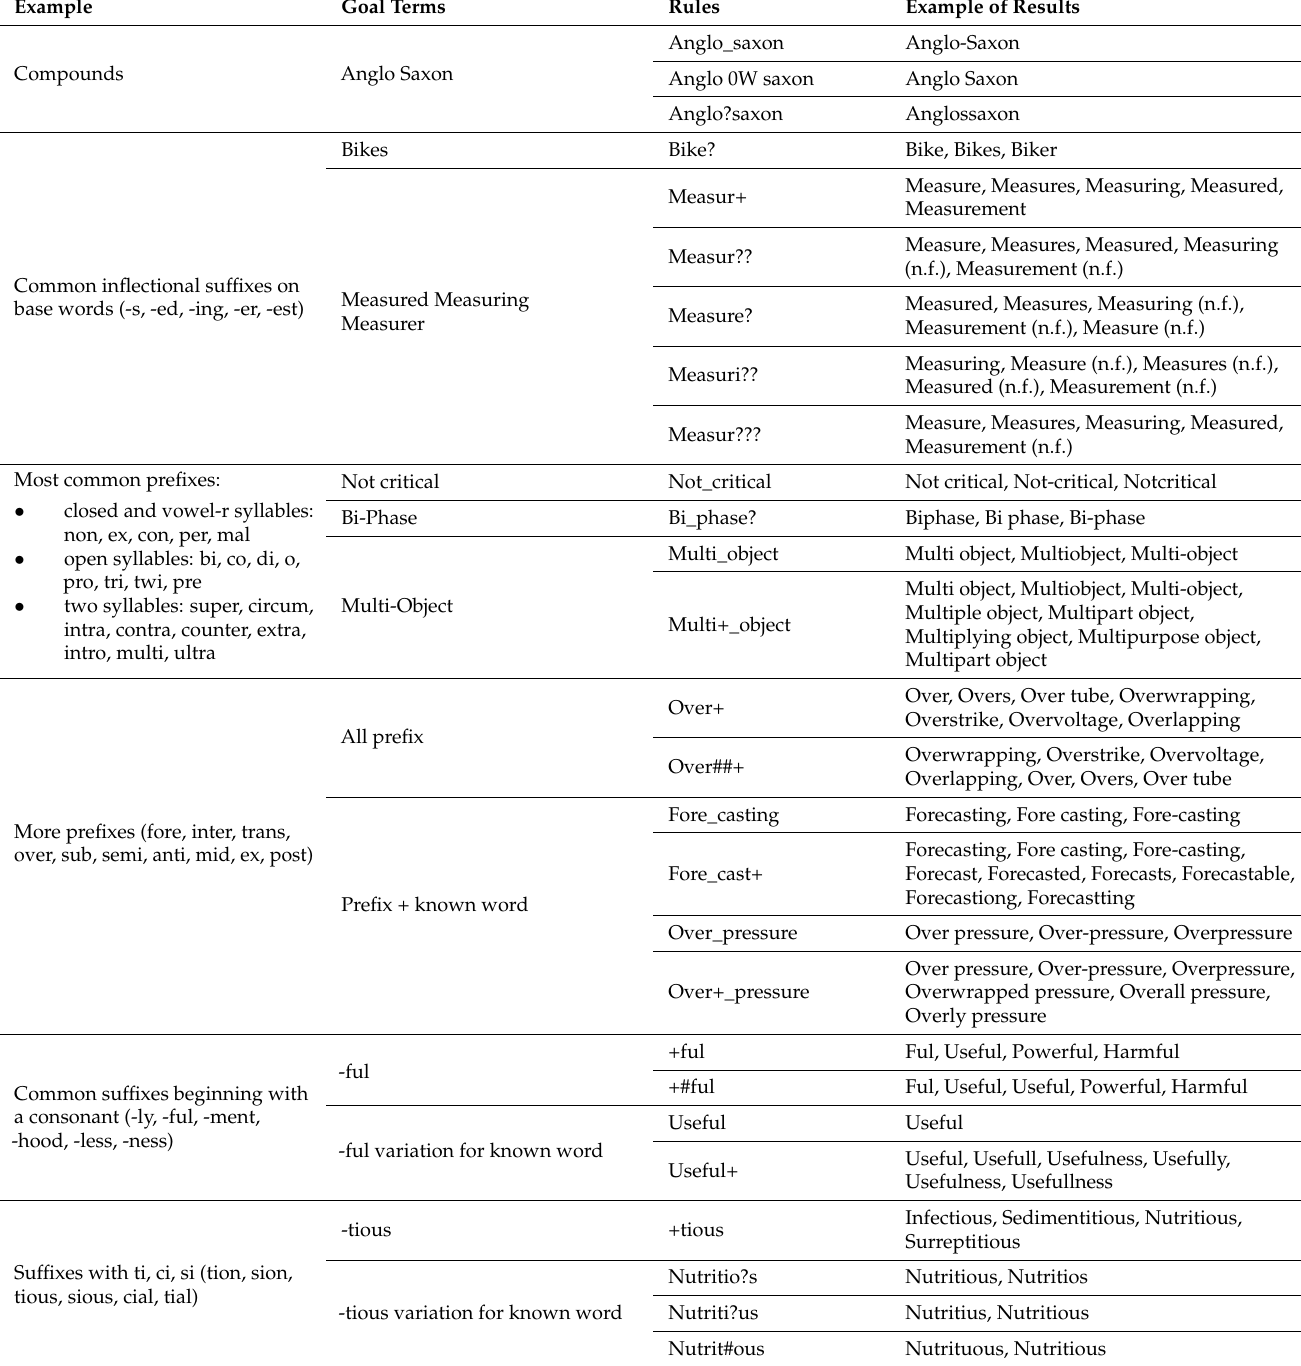
Table 2. Suggested rule-based indications (where “+” = replaces any number of characters, “_” = allows for simultaneous searching of terms that may be written as one or two (ordered) words, “?” = replaces zero or one character, “#” = replaces exactly one